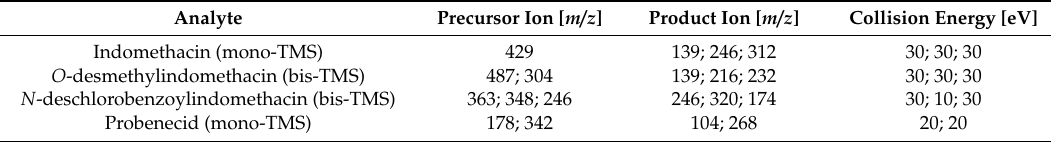
Transitions for GC-MS / MS analysis of indomethacin and its